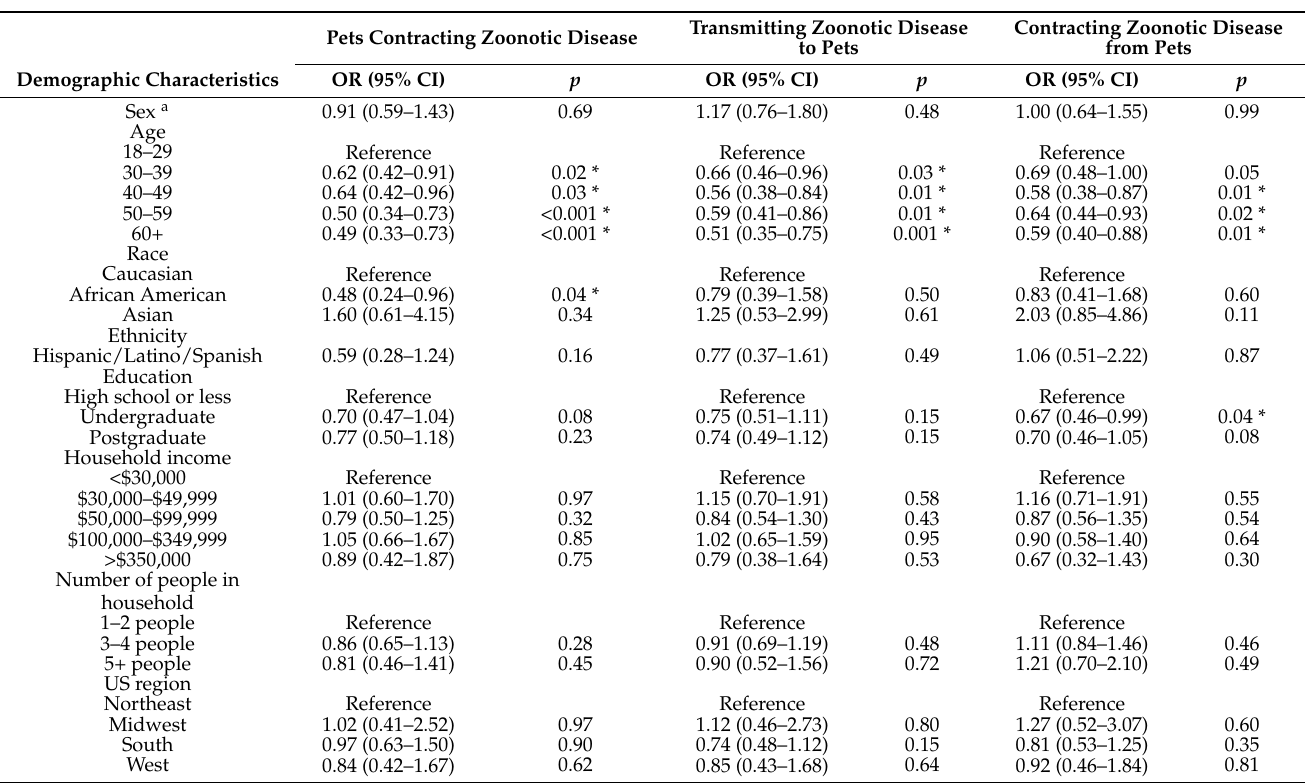
Table 3. Logistic regression models describing the associations between demographic characteristics and perceptions of zoonotic